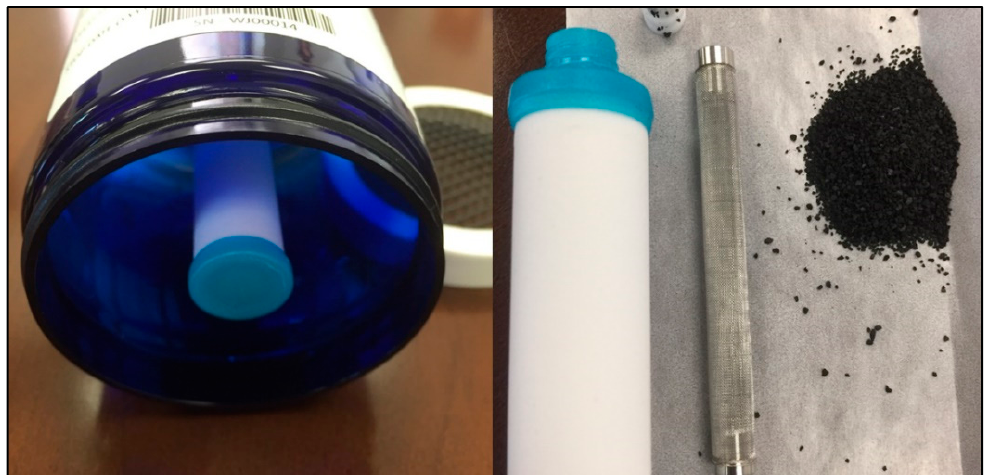
Figure 2. Photos showing the Hg passive air sampler (MerPAS) with a White Radiello diffusive body inside a protective shield and the mesh cover in the background (left), as well as a close up of the diffusive body, stainless steel mesh screen, and sulfur-impregnated activated carbon sorbent (right).